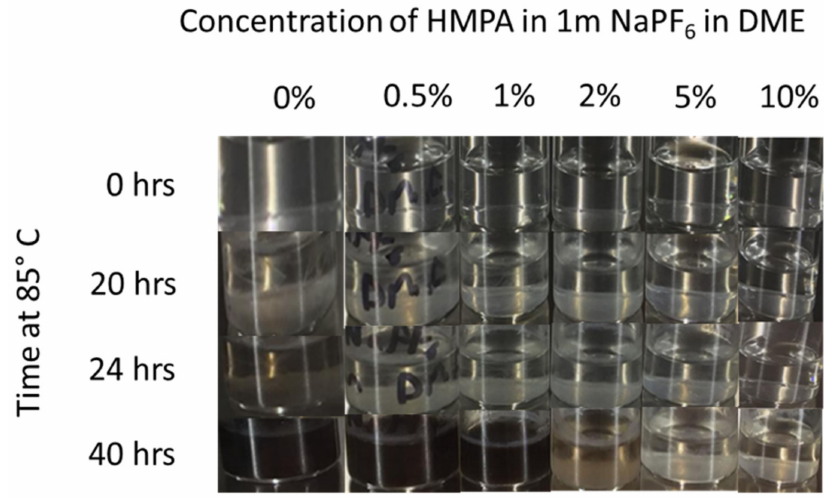
Figure A2. Visual degradation of NaPF 6 in DME with varying concentrations of HMPA at 85 ◦